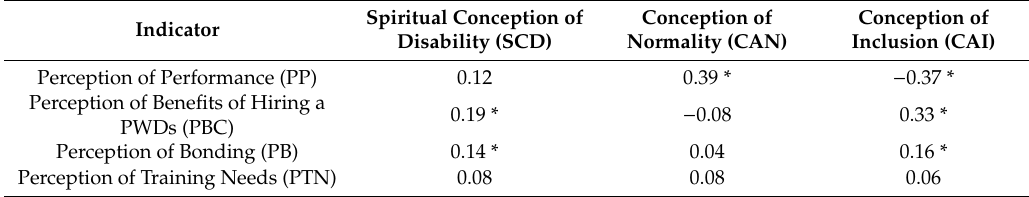
Table 4. Correlation between the indicators created.